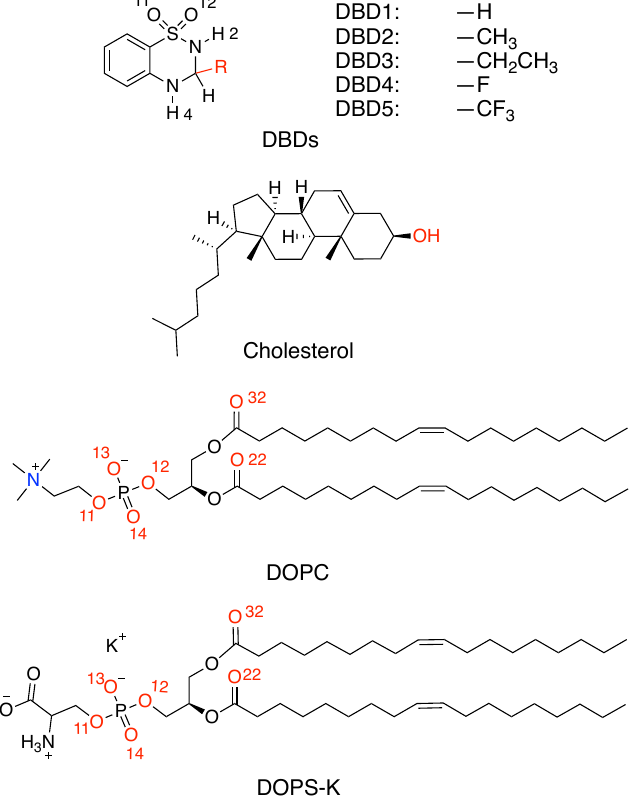
Figure 1. Chemical structures of benzothiadiazine derivatives, phospholipids and cholesterol. Site ‘R’ stands for the five DBD derivatives considered in the present